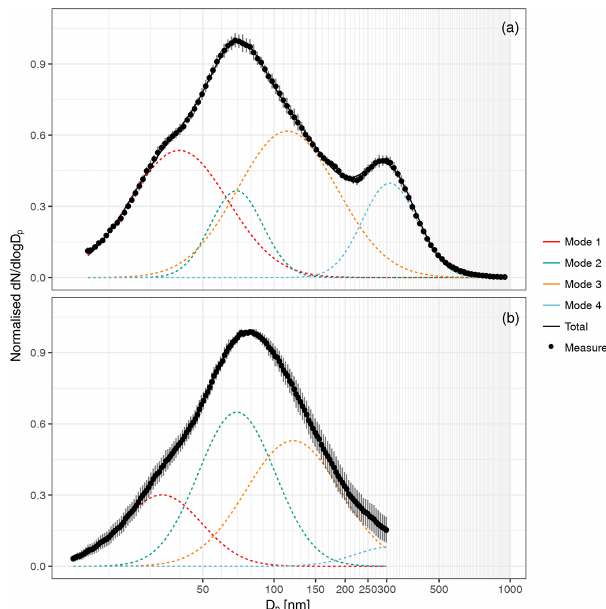
Figure 4. Nascent SSA size distributions from laboratory sea salt measurements (a) and natural seawater measurements (b) . Seawa- ter size distributions are an average of all water samples. Lines rep- resent the fitted modes (dotted) and total fitted distribution (solid), black dots represent measured values, and grey bars indicate the standard deviation in d N/ dlog D p